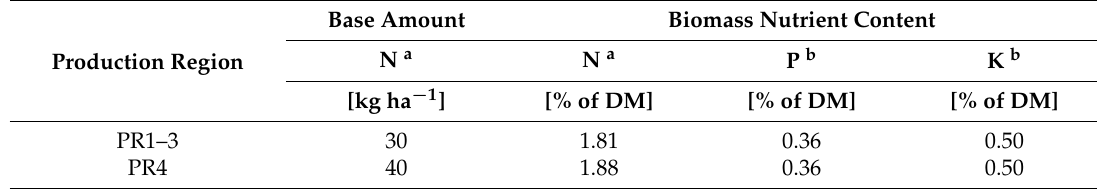
Table A1. Parameters used for the calculation of plant nutrients required for winter wheat fertilization.